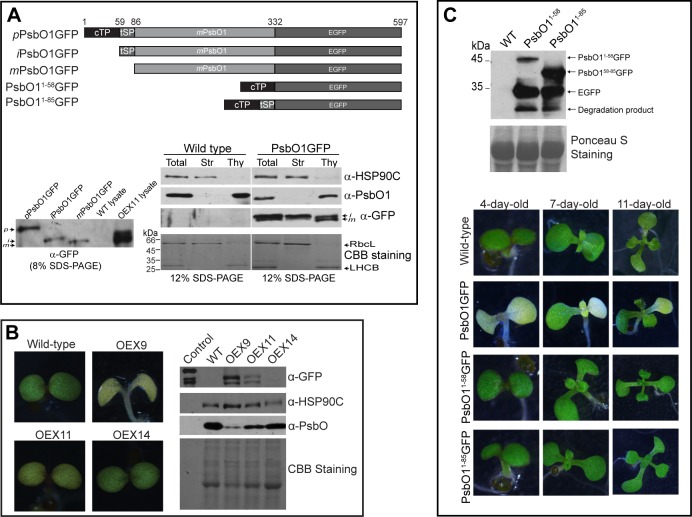
PsbO1GFP transgenic lines show distinct variegation phenotype.(A) Schematic representation of the PsbO11-332GFP, PsbO159-332GFP and PsbO186-332GFP which are also designated as p-, i- or mPsbO1GFP respectively. Control constructs of PsbO11-58GFP and PsbO11-85GFP are also shown. The bottom left immunoblot shows individually expressed pPsbO1GFP, iPsbO1GFP and mPsbO1GFP from E. coli and, the different processing forms in senescing plant lysate stably transformed with pPsbO1GFP (OEX11), which in this study is simply referred as to PsbO1GFP and the Wild type seedling lysate control. The bottom right shows immunoblotting detection of HSP90C, PsbO1 and PsbO1GFP (α-GFP) as well as Coomassie blue staining of stroma (Str) and thylakoid (thy) fractions after fractionation of purified chloroplasts from wild type and PsbO1GFP expressing OEX9 seedlings. Total represents the total chloroplast lysate. (B) T2 seedlings of 3 independent transgenic lines (OEX9, OEX11 and OEX14) expressing PsbO1GFP and wild-type control (Col-0), grown on ½ MS medium for 5 days after germination (5-DAG). Immunoblot analysis was performed with a total of 10 μg total proteins by using anti-GFP, anti-PsbO and anti-HSP90C antibodies. (C) T2 seedlings expressing PsbO1GFP, PsbO11-58GFP and PsbO11-85GFP at 4-, 7- and 12-DAG. The top immunoblot for 2μg of total proteins indicates the expression of PsbO11-58GFP and PsbO11-85GFP in transgenic seedlings by using anti-GFP antibody and Ponceau S staining.